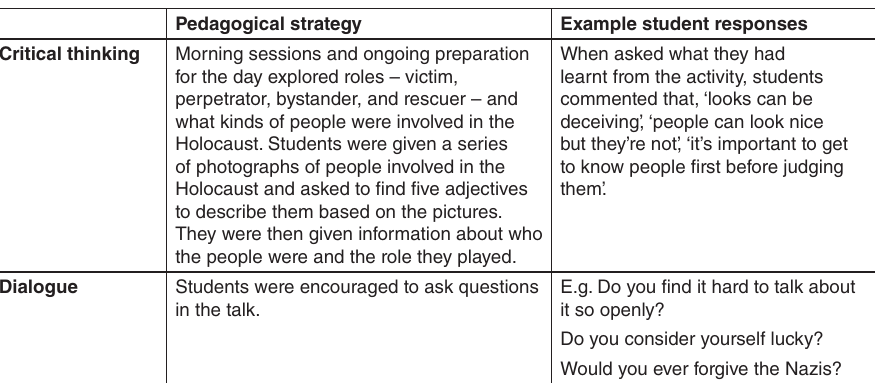
Table 3: Y9 Holocaust